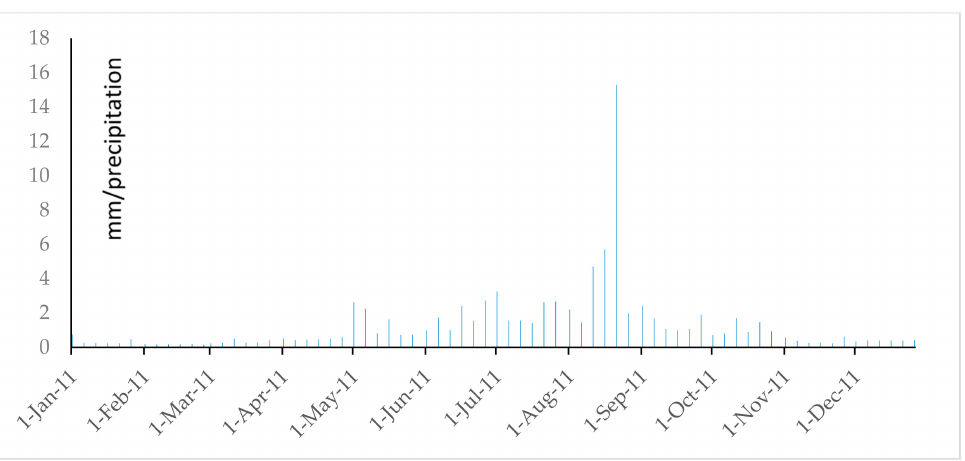
Figure A39. Precipitation of Denko County in